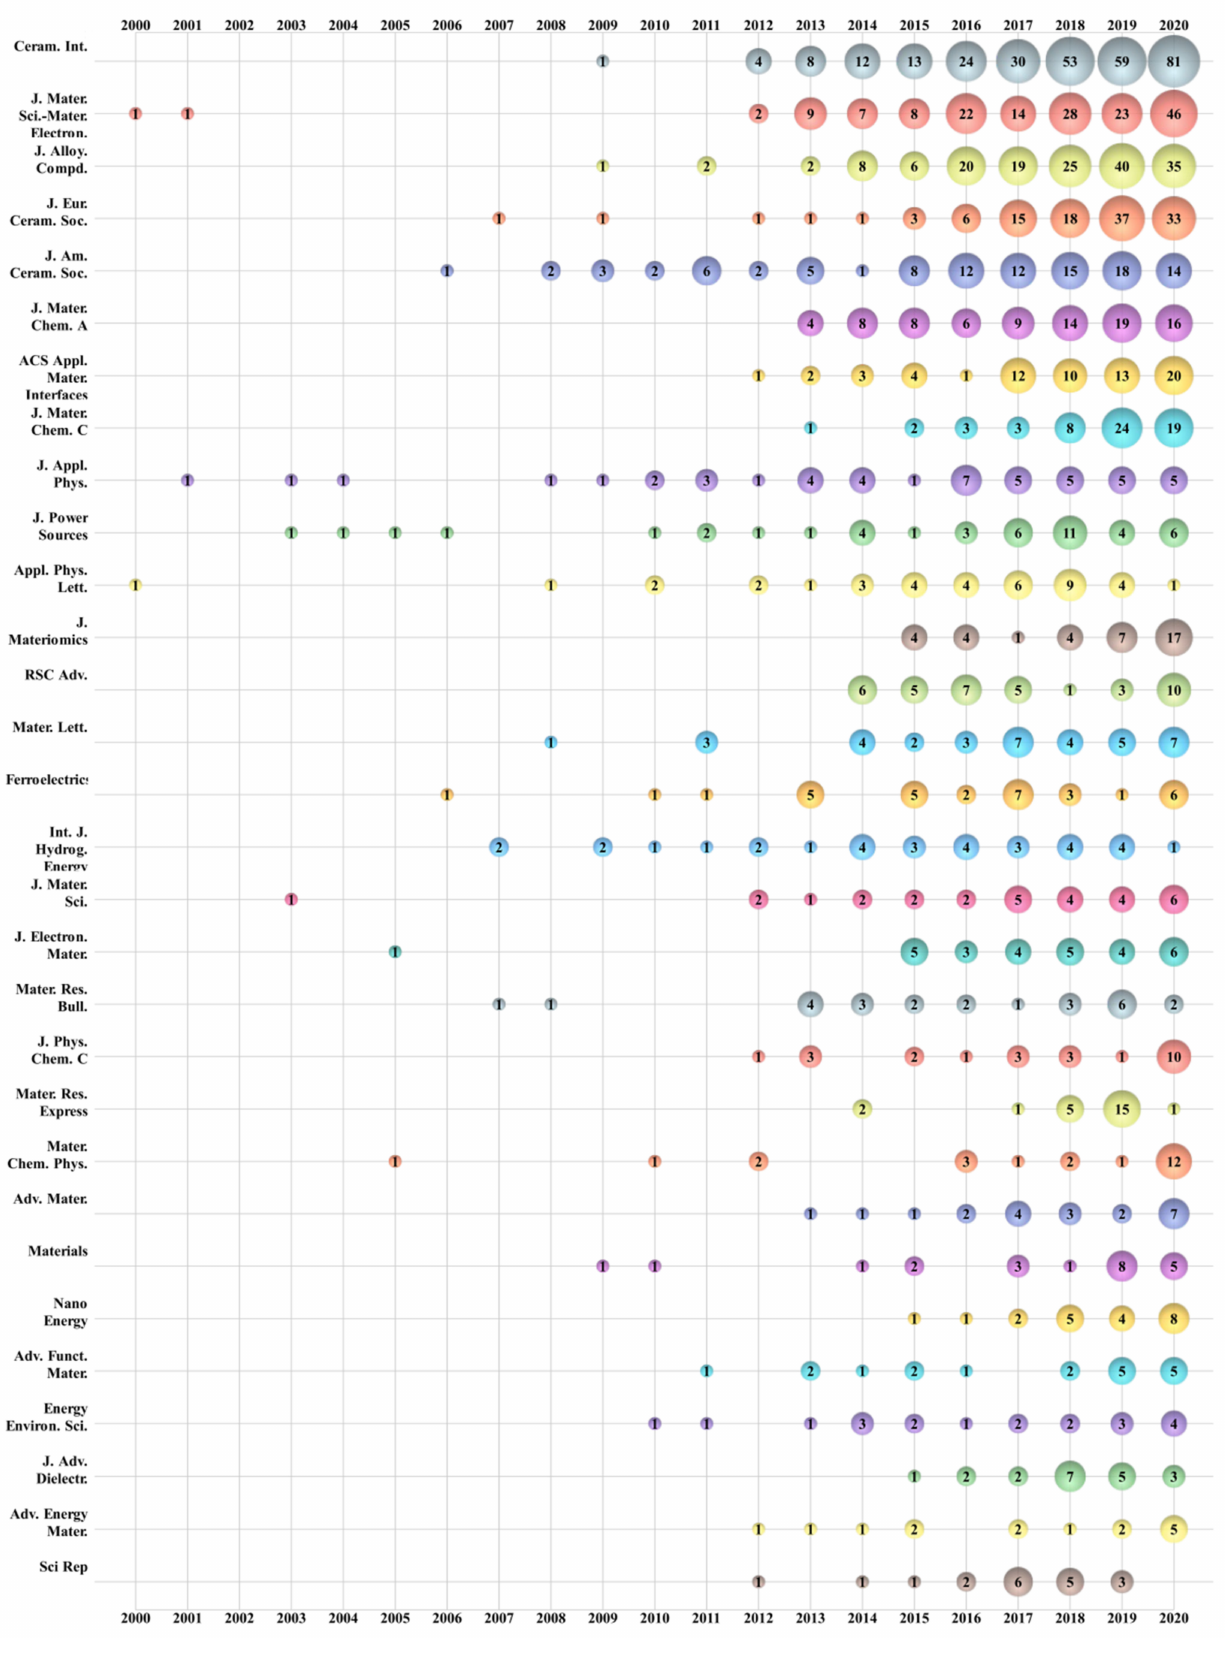
Figure 5. Bubble chart of the top 30 most productive publications by